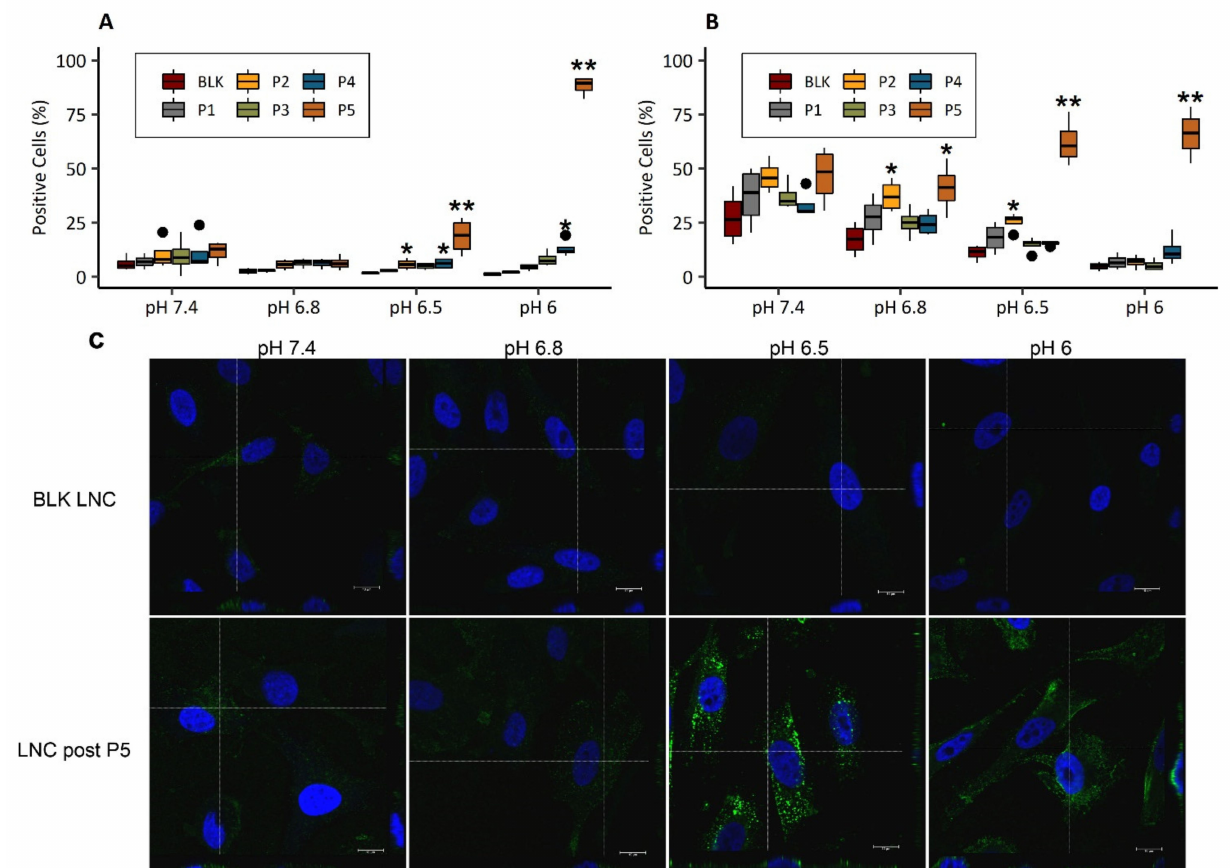
Figure 6. LNC internalization in B16F10 ( A ) and in SK-Mel 28 cells ( B , C ) assessed by FACS analysis ( A , B ) and by confocal imaging ( C ). Cells were treated in various pH media (7.4, 6.8, 6.5, 6) with 250 µ g/mL of fluorescent LNC for 2 h. For cell uptake assessed by FACS analysis ( A , B ), data are expressed as a boxplot. Each box represents 50% of the distribution (interquartile range: 25th percentile–75th percentile). Median is marked as a black line in each box. Extending lines from boxes show minimum and maximum values. Outlier data are plot as black circles. Statistical analysis was performed on results ( n = 4) with Kruskal–Wallis, post hoc Dunn’s, correction Hochberg, blank LNC (“BLK LNC”) was used as control, ** p < 0.01, * p < 0.05. For confocal imaging ( C ) of SK-Mel28 cells, after 2 h incubation with blank LNC (“BLK LNC”) and LNC post inserted by C 18 H 37 -P(NVP 21 -co-Vim 15 ) (“LNC post-P5”), at pH 7.4, 6.8, 6.5 and 6. The cell nucleus was stained with DAPI (in blue), and the green signal comes from the fluorescent LNC. Scale bars correspond to 10 µ m. The objective used: 63x/NA 1.40 oil with 2x numerical zoom. Orthogonal sections are localized by the dotted